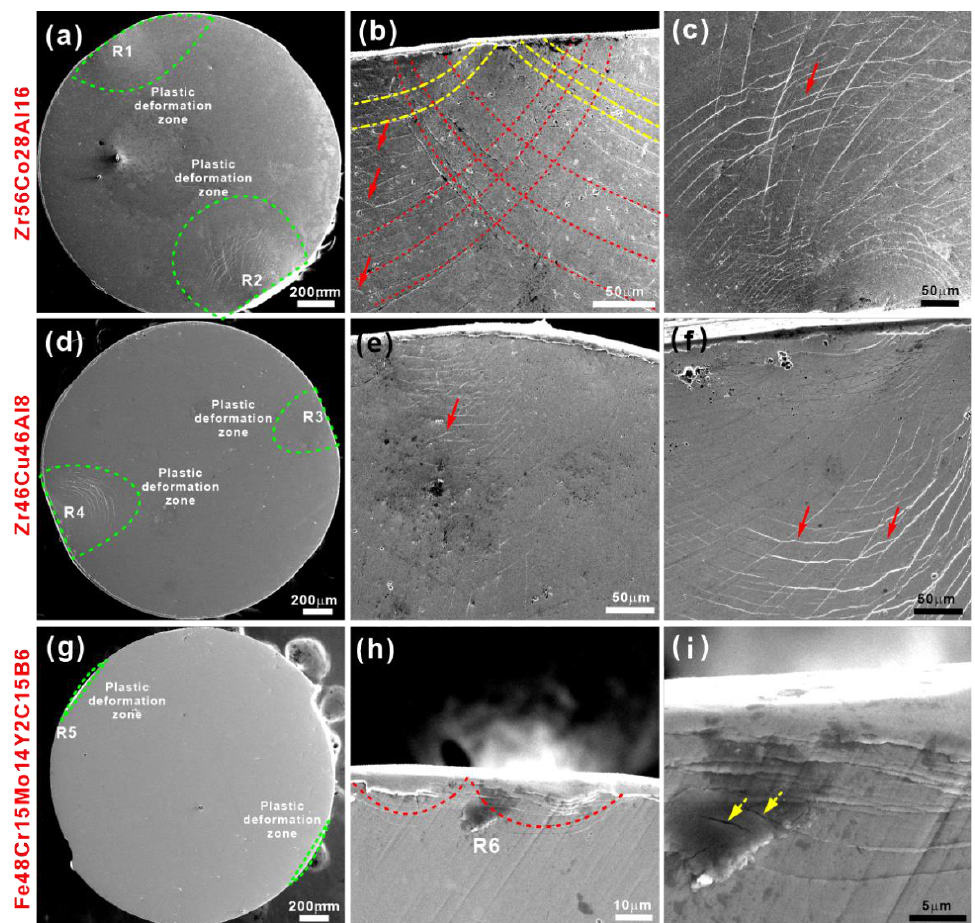
Figure 2. Overall morphologies of the ( a ) Zr 56 Co 28 Al 16 , ( d ) Zr 46 Cu 46 Al 8 , and ( g ) Fe 48 Cr 15 Mo 14 Y 2 C 15 B 6 BMGs after pre-plastic deformation and the enlarged SEM images of the regions ( b ) R1, ( c ) R2, ( e ) R3, ( f ) R4, ( h ) R5, and ( i ) R6, respectively; The green dotted lines represent the plastic deformation zone induced by PPD treatments. The yellow dot – dash lines represent the semi-circular shear bands developed from the initial shear bands induced by PPD treatments. In contrast, the red dotted lines represent the induced semi-circular shear bands during the later stage of PPD treatments. The solid red arrows represent the dense wavy shear bands between semi-circular ones, and the dotted yellow arrows represent micro-cracks.